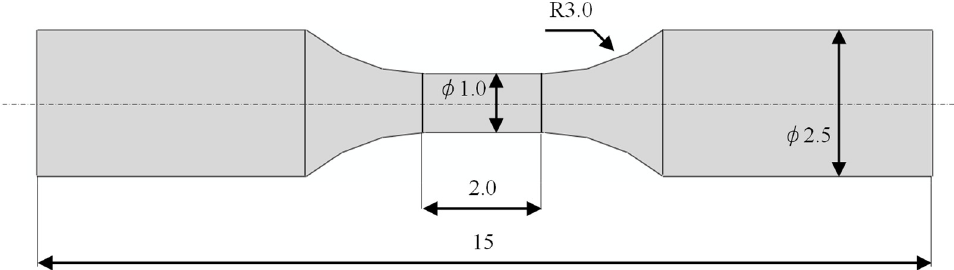
Figure 3. Small round-bar specimen for tensile tests. Dimensions are in mm.